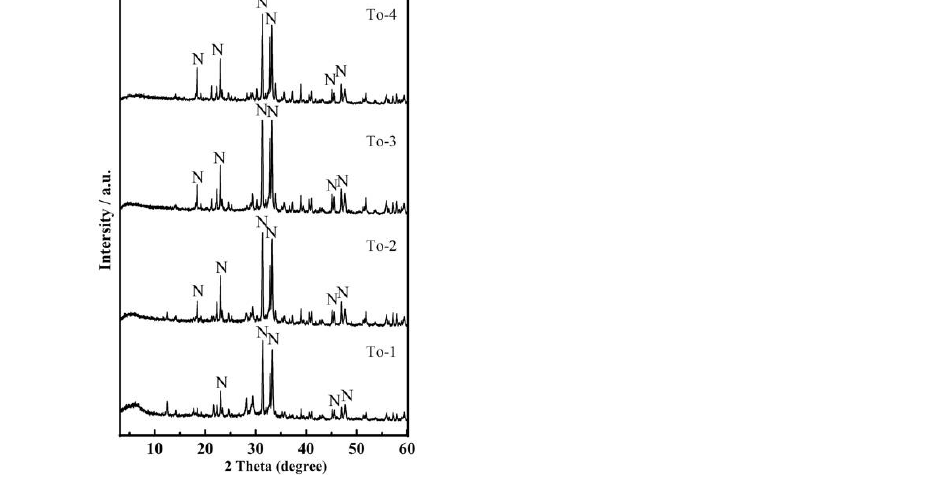
Figure 3. XRD pattern of products synthesized at different temperatures for 12 h. N—NaCaHSiO 4 ; A—Ca(OH) 2 ; T—11Å-TA; C—Ca 3 Al 2 O 6. XRD patterns of products obtained from the hydrothermal reaction with various Ca/Si molar ratio at 200 °C are shown in Figure 4. The hydrothermal time was fixed at 12 h. The observed peaks of main phases in ARE fully disappeared. Si and Ca were all dis- solved and completely used for new mineral formation. All samples show characteristics peaks of 11Å-TA. This highlights the possibility of crystallization of the material over a wider Ca/Si molar ratio range. When the ratio was 0.8, the crystal phases in the product were mainly 11Å-TA, with quartz and analcime detectable only in trace amounts. Accord- ing to a primitive inference from Hsiao [26], the presence of Na + and a basic solution en- vironment are required for the synthesis of analcime. NaCaHSiO 4 was sufficiently alkaline to effect the decomposition of itself and produce sufficient SiO 32− , Na + and alkalinity with- out addition of any more strongly basic reaction medium during hydrothermal reaction. In addition, some SiO 2 did not transform into TA but into quartz indicating that Ca source was insufficient. As Ca/Si molar ratio increased, the quartz and analcime characteristic peaks disappeared, while relatively strong reflections of Ca 3 Al 2 O 6 were detected. Accord- ing to the above analyses, hydrothermal treatment of AER without addition of extra silica and calcium source formed 11Å-TA. The reactions were expressed as follows: NaCaHSiO 4 + OH − → SiO 32− +Na + Ca(OH) 2